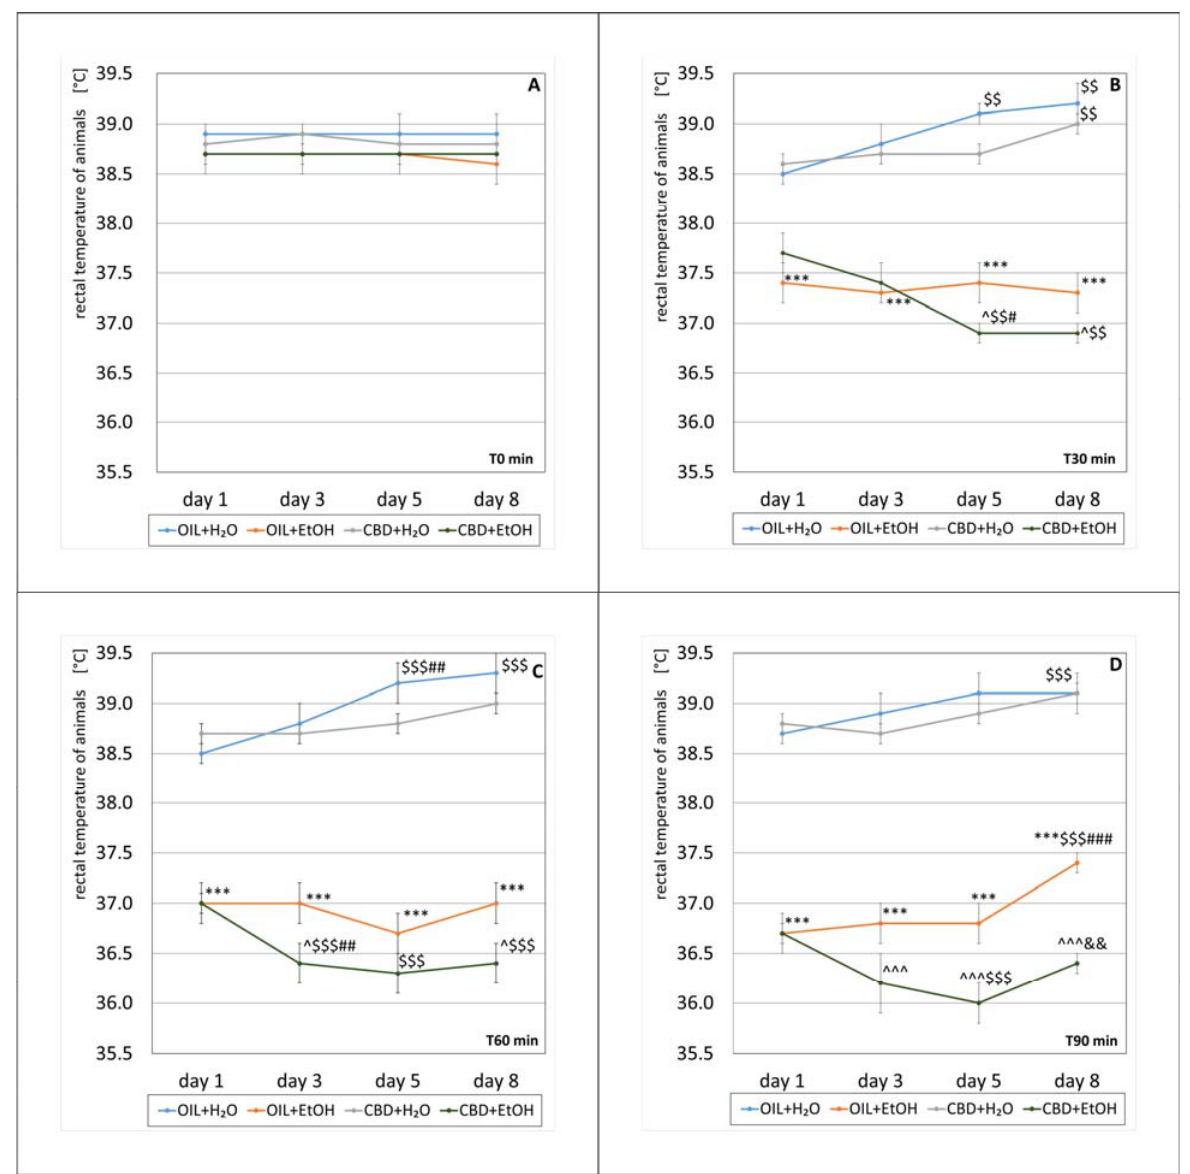
Figure 3. The effect of repeated once ‐ a ‐ day administration for 8 days of CBD (cannabidiol; 20 mg. kg, p.o.) or OIL (rapeseed oil) on EtOH (ethanol; 3.0 g/kg/day, i.p.) or H 2 O (water for injection) action, expressed by the changes in rat rectal temperature on selected days (1, 3, 5, 8) at T0 min ( A